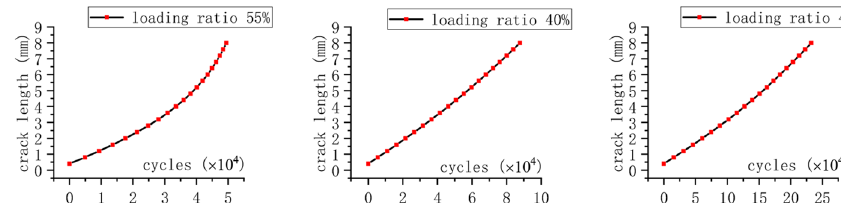
Fig. 17 Predictive value of corrosion fatigue crack life